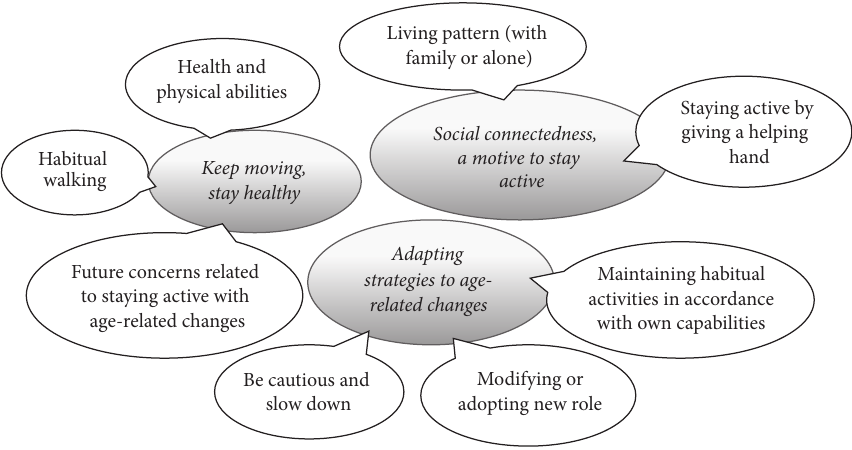
Figure 1: Central narratives and related significant